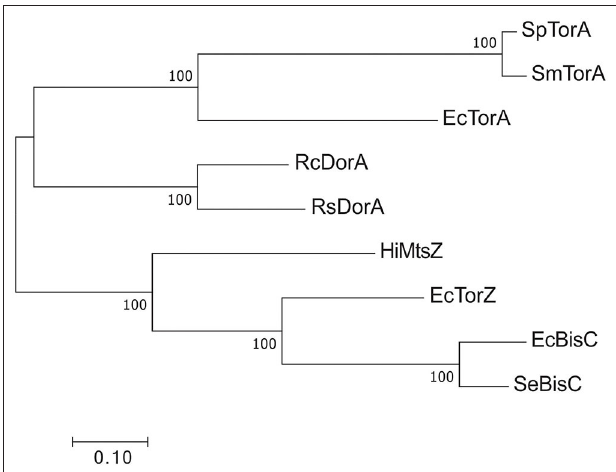
FIGURE 6 | Phylogenetic relationships of Dor/Tor-type S- and N-oxide reductases of the DMSOR family. Sequences were aligned using MUSCLE in MEGA7 (Kumar et al., 2016) and phylogenetic relationships determined using the maximum-likelihood method. Robustness testing used bootstrapping (500 cycles), bootstrap values above 80 are shown near relevant nodes. All sequences were downloaded from the NCBI protein database. Grouping was well-supported by the bootstrap values. Sp TorA, Shewanella putrefaciens (WP_086903686.1); SmTorA, Shewanella massilia (WP_115334087.1); RcDorA, Rhodobacter capsulatus (WP_013068552.1); RsDorA, Rhodobacter sphaeroides (WP_011338998.1); HiMtsZ, Haemophilus influenzae (WP_0 108 69026.1); Se BisC, Salmonella enterica (WP_183053592.1); EcTorA, Escherichia coli (WP_001063164.1); EcTorZ (WP_000176781.1); EcBisC